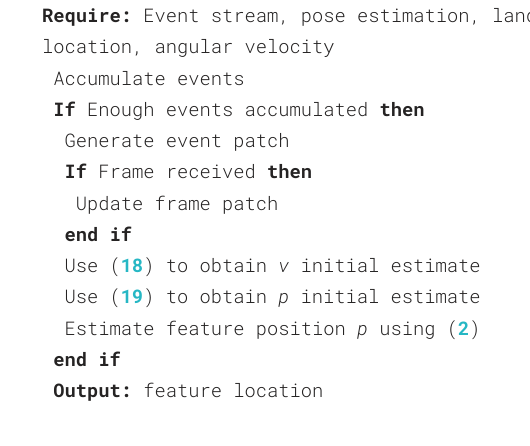
Algorithm1. EKLTadaptedforclosedloop